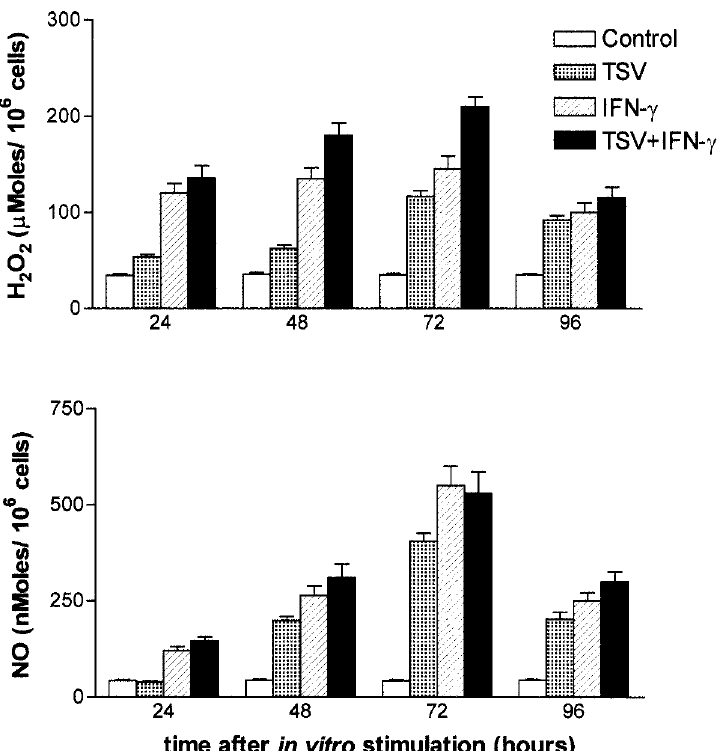
FIG. 7. H 2 O 2 and NO release by peritoneal macrophages. Peritoneal macrophages were stimulated by 55 m g/ml of TSV or IFN- g (10ng/ml) or TSV + IFN- g . H 2 O 2 and NO were determined as described in Fig. 6. Each point represents the mean ± standard deviation value of samples from five experiments in different groups of five